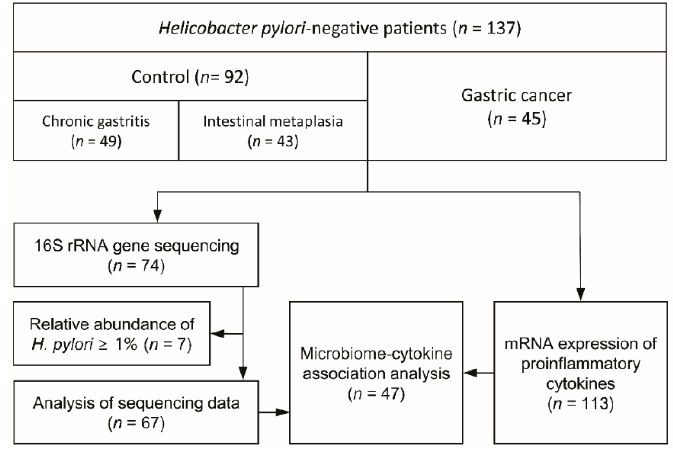
Figure 1. Study flow. Table 1. Demographics of the patients included in this study.